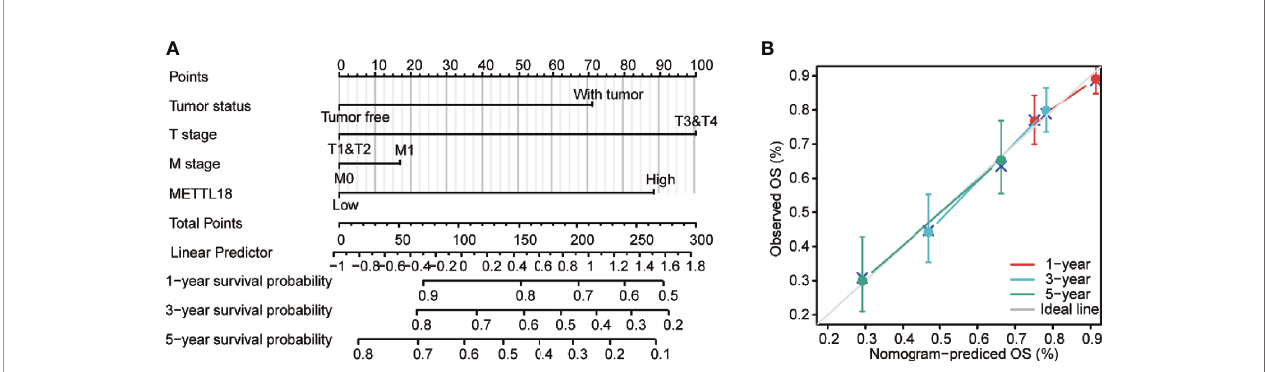
FIGURE 6 | A quantitative method to predict HCC patients ’ probability of 1, 3, and 5 year OS. (A) A nomogram for estimating the probability of 1, 3, and 5 year OS for HCC patients. (B) Calibration plots of the nomogram for evaluating the probability of OS at 1, 3, and 5 years. HCC, hepatocellular carcinoma; OS, overall